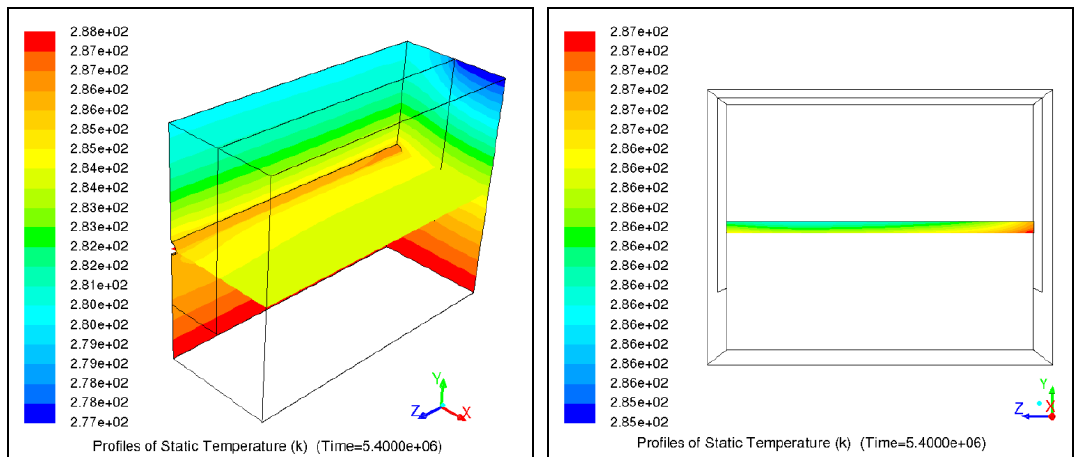
Figure 17. Temperature distribution on the horizontal and vertical planes, air flow rate equal to 450 m 3 /h, with λ = 3 W/(m K), 20 February, at 12